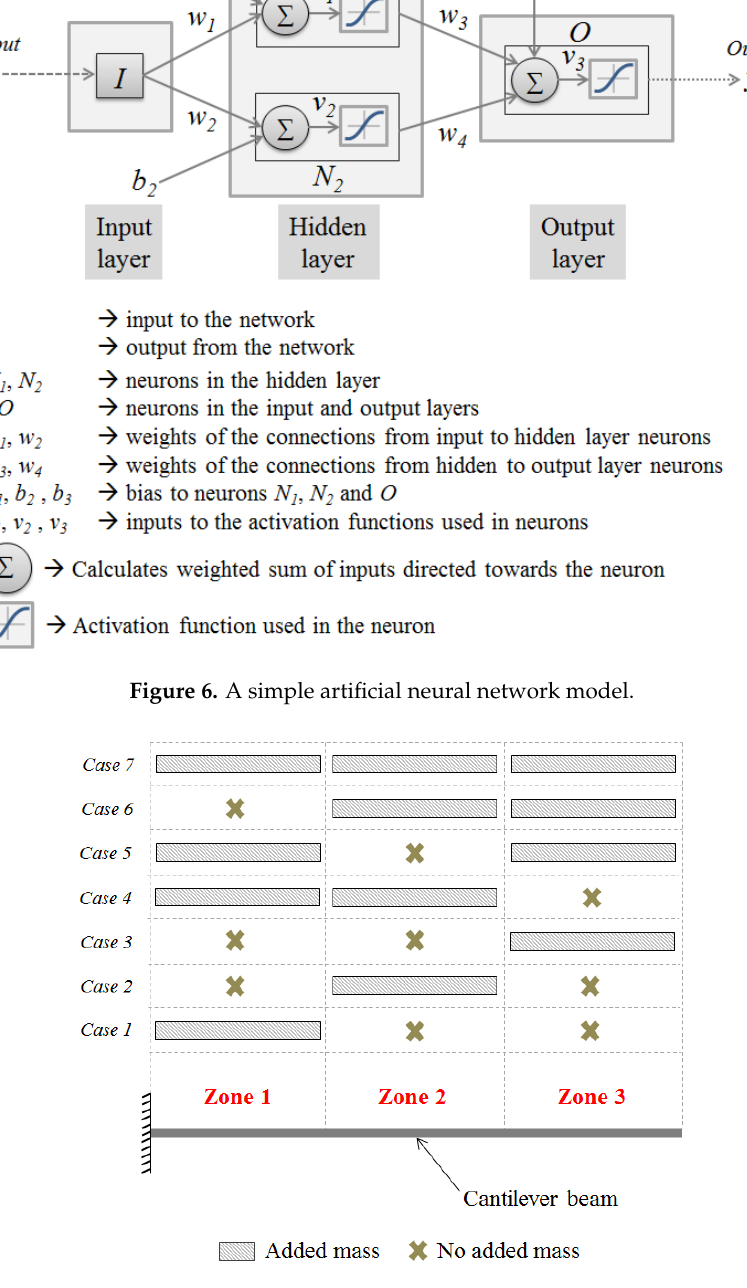
Figure 7. Cantilever beam with two possibilities of added mass in three zones defined on the beam. Table 4. Natural frequencies of the beam calculated with added mass of 27